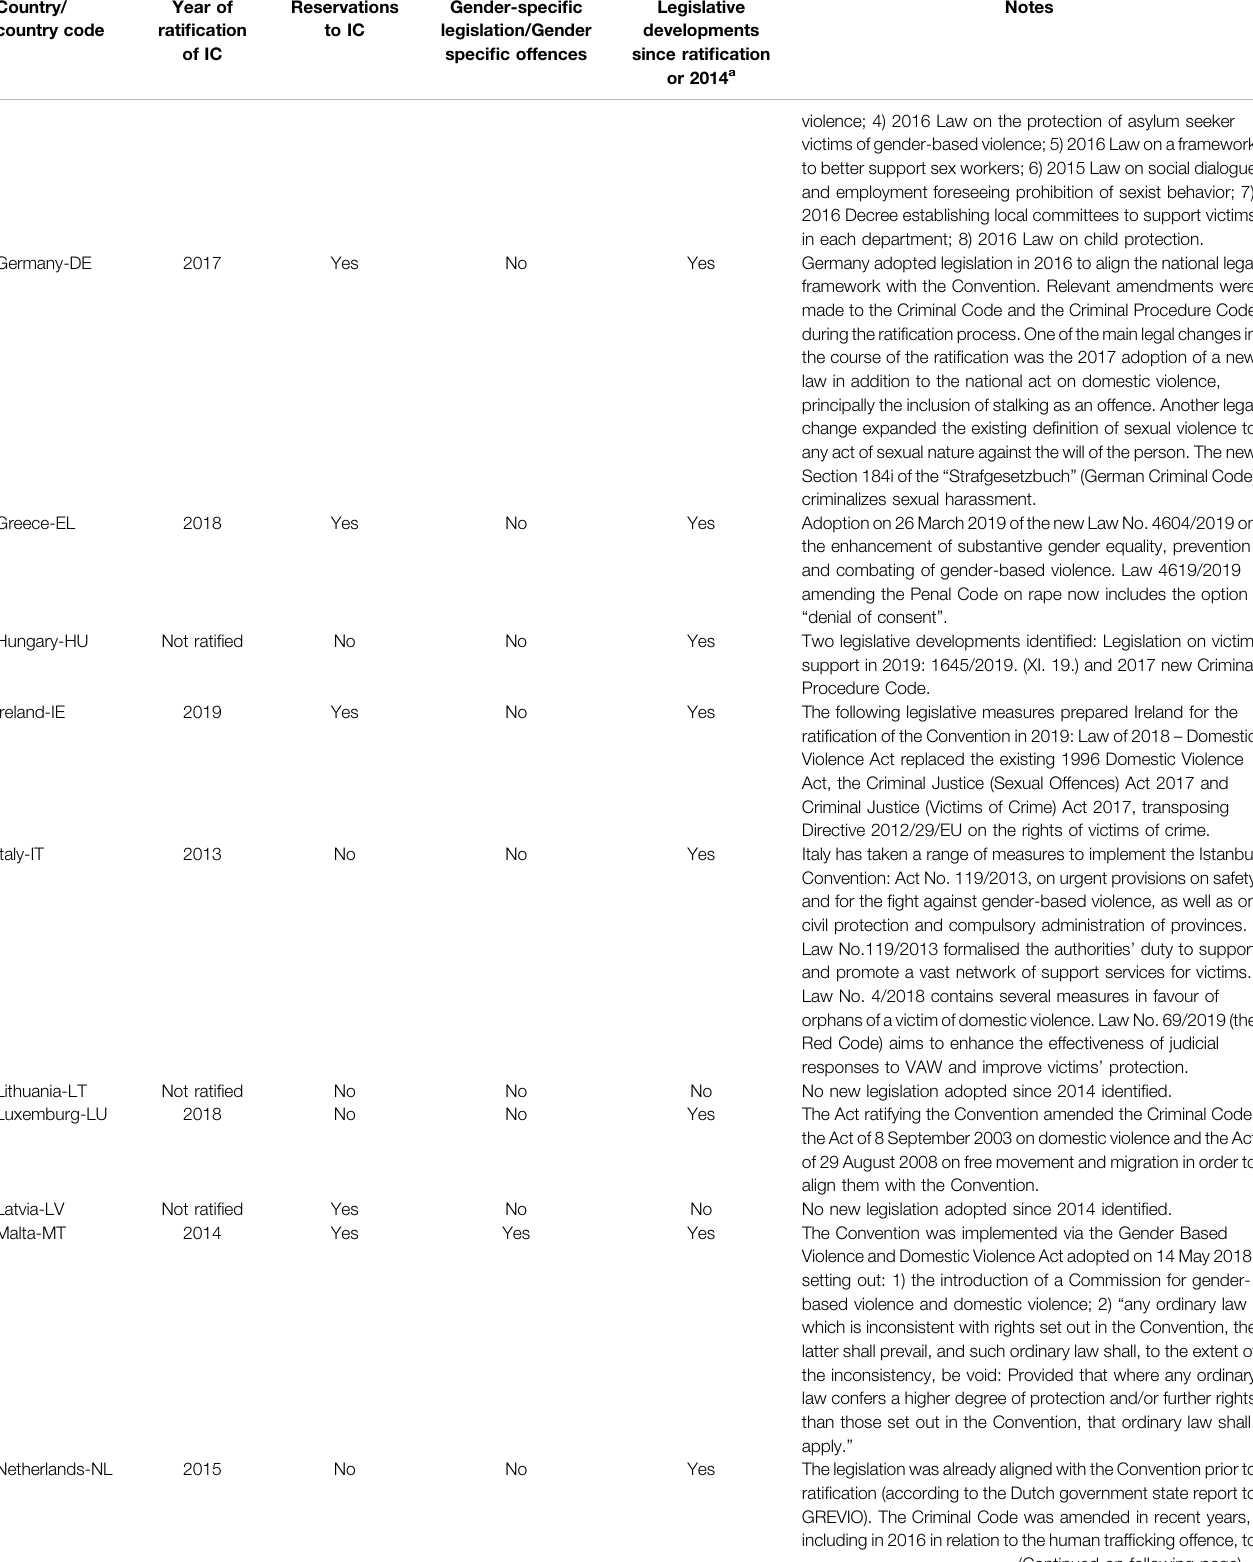
TABLE 1 | ( Continued ) Overview rati fi cations, reservations and legislative developments [adapted from Meurens et al. (2020)]. Country/ country